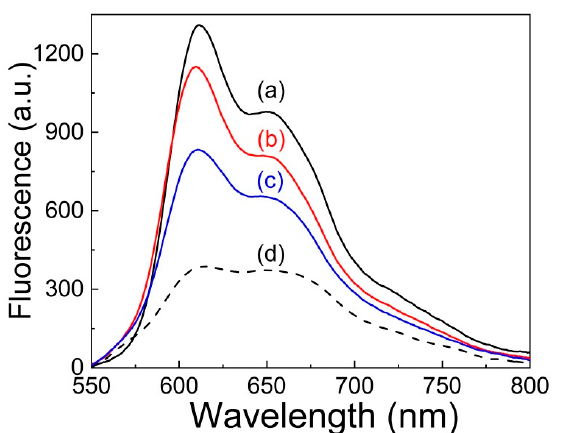
Figure 2. Fluorescence of dyes that were extracted in aqueous solutions from the leaves of the Tradescantia pallida purpurea plant at different pH values: (a) 3.96, (b) 5.25, (c) 6.83, and (d) 8.02 ( λ = 532 nm, P e ≈ 50 mW, concentration of 0.85 g/mL and 1 cm quartz cuvette).